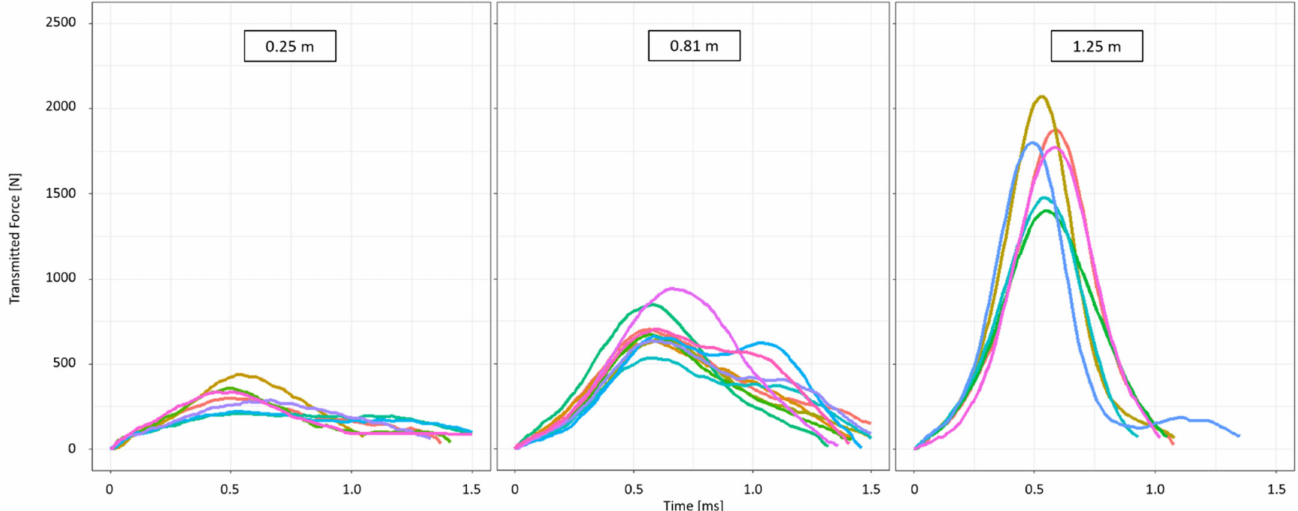
Figure 7. Force-time diagrams for fresh Citrus × limon samples at different drop heights (0.25 m ( n = 7), 0.81 m ( n = 10), 1.25 m ( n = 6)). For clarity, only 10 out of 208 samples tested at a drop height of 0.81 m are plotted. The drop-weight tests were performed with a cylindrical impactor (mass = 0.61